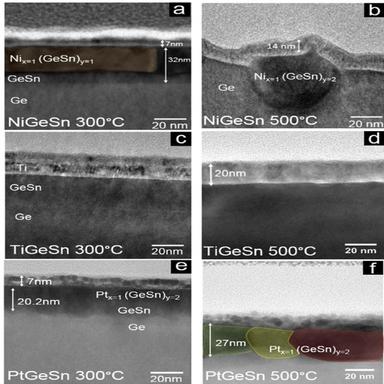
Representative cross section TEM images at the same magnification with related mixing depth of a) NiGeSn at 300 °C, b) NiGeSn at 500 °C, c) TiGeSn at 300 °C, d) TiGeSn at 500 °C, e) PtGeSn at 300 °C, f) PtGeSn at 500 °C. Colour coded areas depict different grains in the layer.